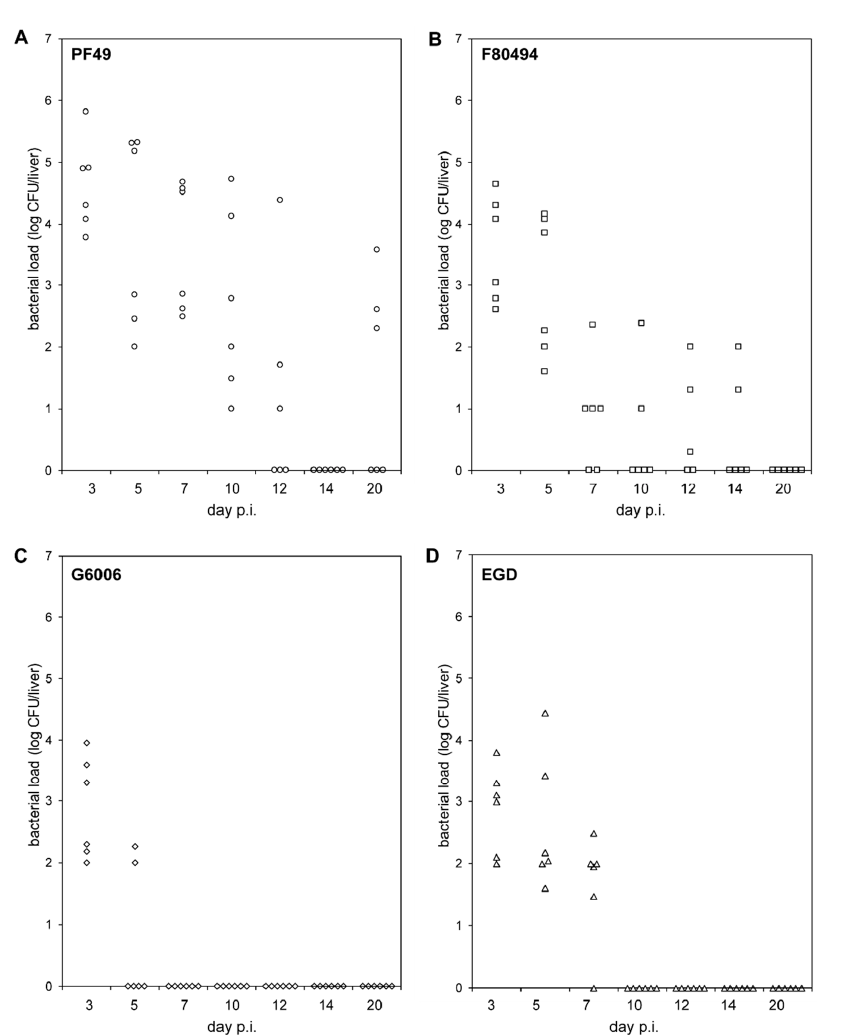
Figure 1. In-vivo pathogenicity. Bacterial loads (log CFU) in the livers of BALB/C mice ( n = 6) intra- venously infected with strain PF49 (( A ), circle), F80594 (( B ), square), G6066 (( C ), rhombus) and